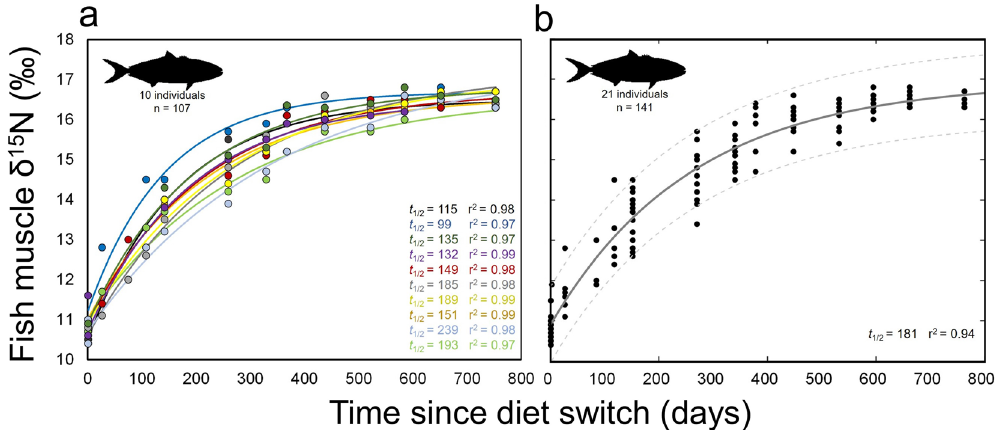
Figure 2. Change of δ 15 N with time after diet switch in muscle of ( a ) individual and ( b ) grouped captive California yellowtail Seriola dorsalis . ( a ) Points represent individual δ 15 N measurements and lines show associated model fits, colored by individual. Values t 1/2 is the half-life of 15 N for each individual and r 2 values are shown for model fit to each individual. Data shown only for yellowtail that were in captive conditions for enough time to reach steady-state with new diet. ( b ) Model fit (solid line) and 95% confidence bounds (dashed lines) for all yellowtail sampled. Grouped data include fish that were removed from captivity or suffered mortality during the experimental period.